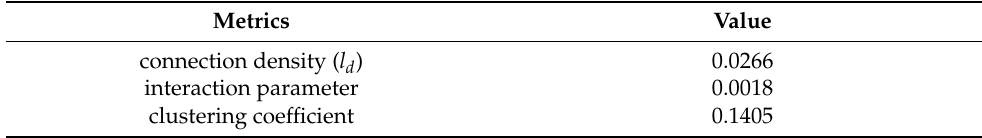
Table 2. Delay propagation causality network metric